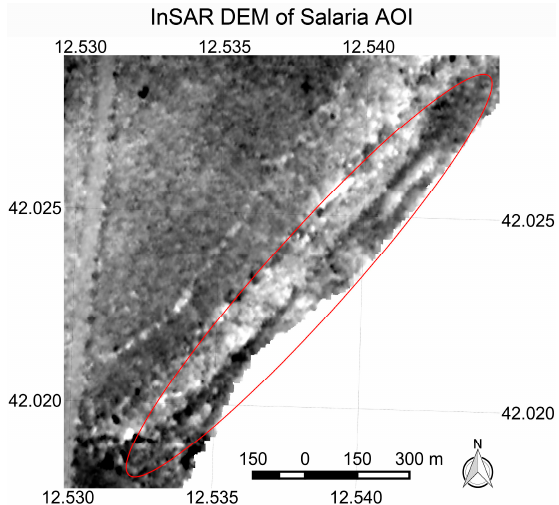
Figure 47. DEM over the Salaria AOI derived from InSAR using the CSK Stripmap image pair acquired on 10 and 26 August 2012. Red ellipse shows location of the residue of the ancient Via Salaria. The DEM is very noisy, but the residue of the ancient Via Salaria can clearly be